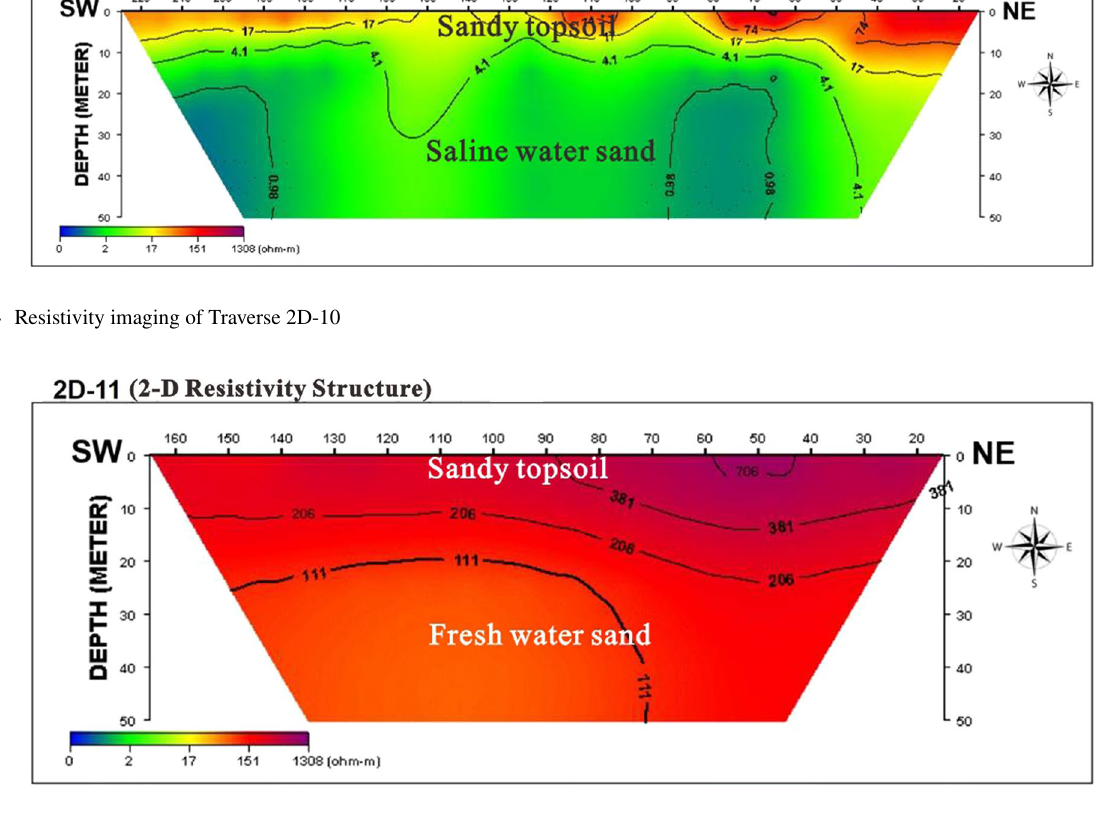
Fig. 15 Resistivity imaging of Traverse 2D-11